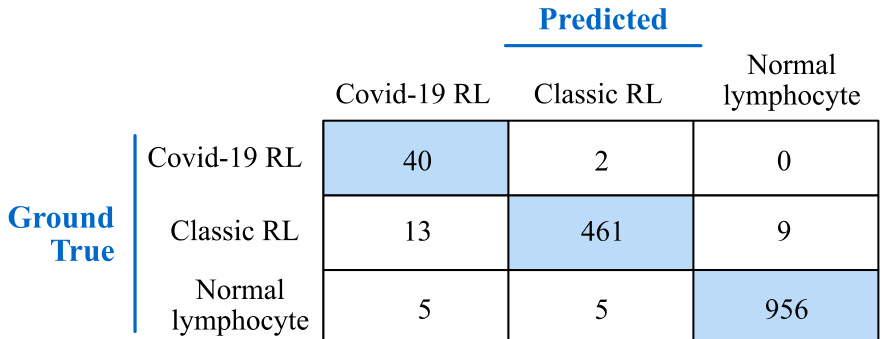
Figure 5. Confusion matrix for the classification of the test set. The cells are classified into normal lymphocytes, COVID-19 reactive lymphocytes, and classic reactive lymphocytes. The results are expressed in cell